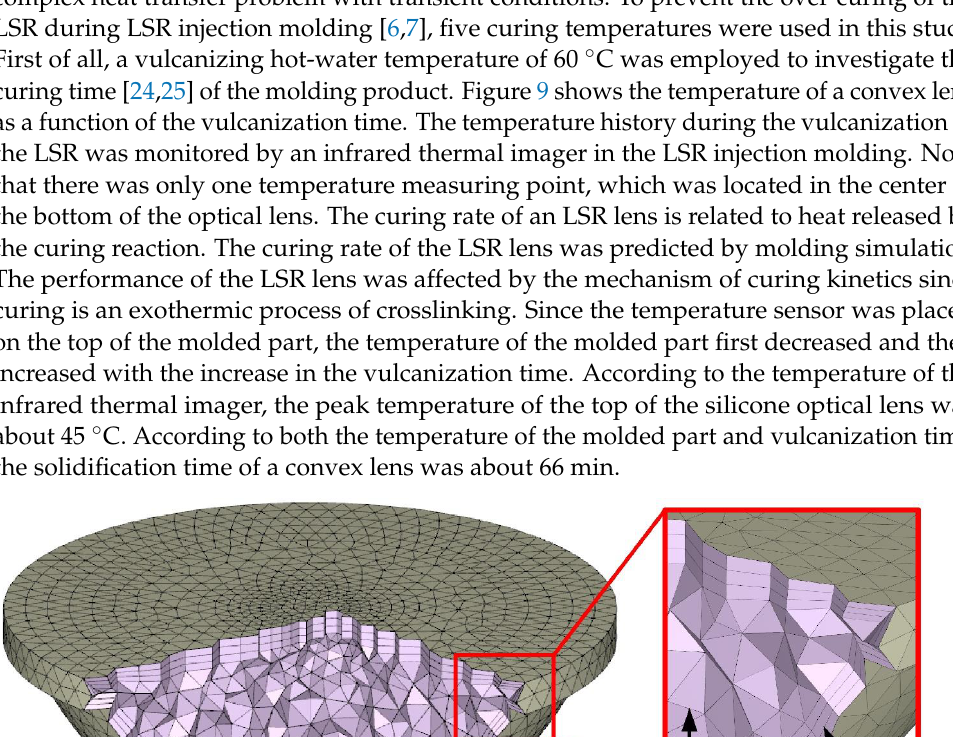
Figure 6. A rapid tool with CHC and CCC for LSR injection molding.